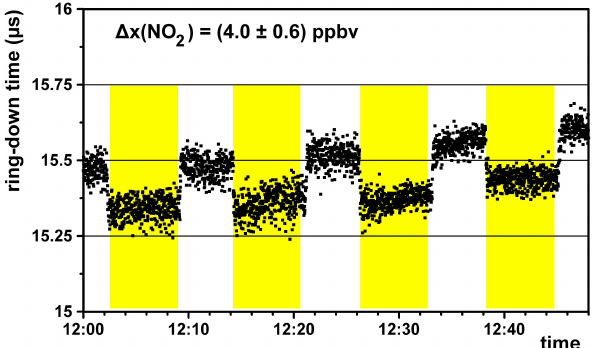
Fig. 11. eCL HO 2 calibration measurement at an inlet pressure of Fig. 11. eCL HO calibration measurement at an inlet pressure of 2 300hPa . Left y-axis: Reactor 1, red – background, black – ampli- 300hPa. Left y axis: reactor 1, red – background, black – ampli- fication mode measurement. Right y-axis: Reactor 2, blue – back- ground,orange–amplificationmodemeasurement.Thedurationof fication mode measurement. Right y axis: reactor 2, blue – back- each HO 2 volume mixing ratio measurement was 10 minutes. ground, orange – amplification mode measurement. The duration of each HO 2 volume mixing ratio measurement was